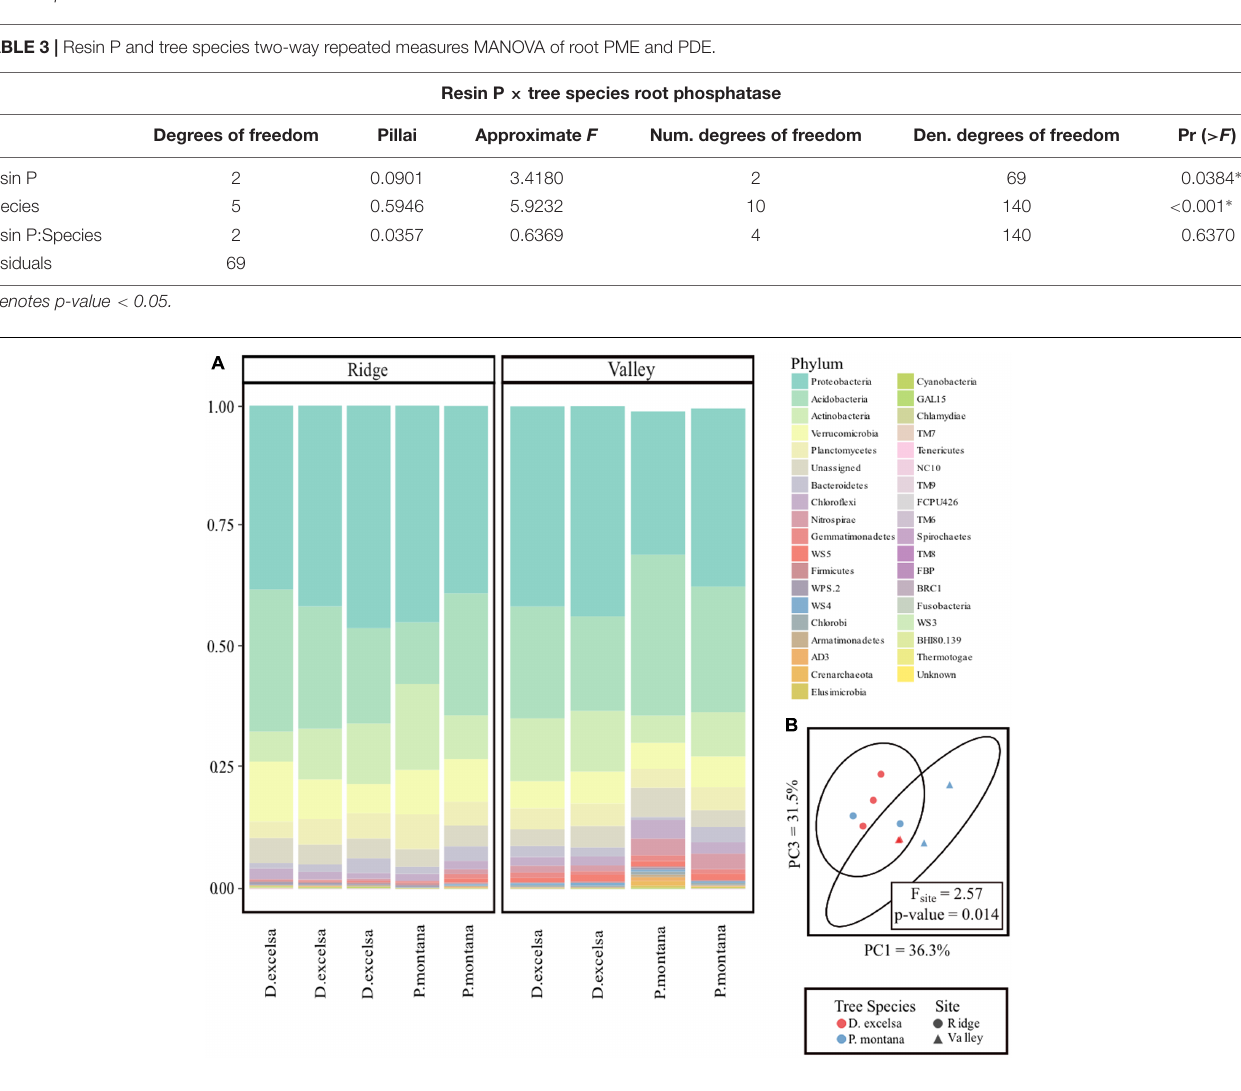
and 19 to 34% in the Ridge. The relative abundance plot